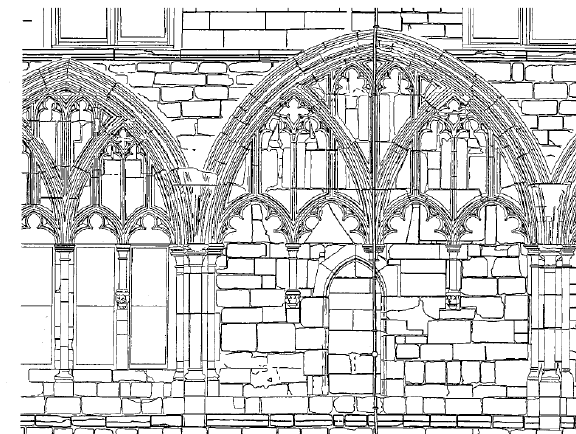
Figure 1. Stone by stone records for Battle Abbey, photogrammetric survey (after English Heritage,